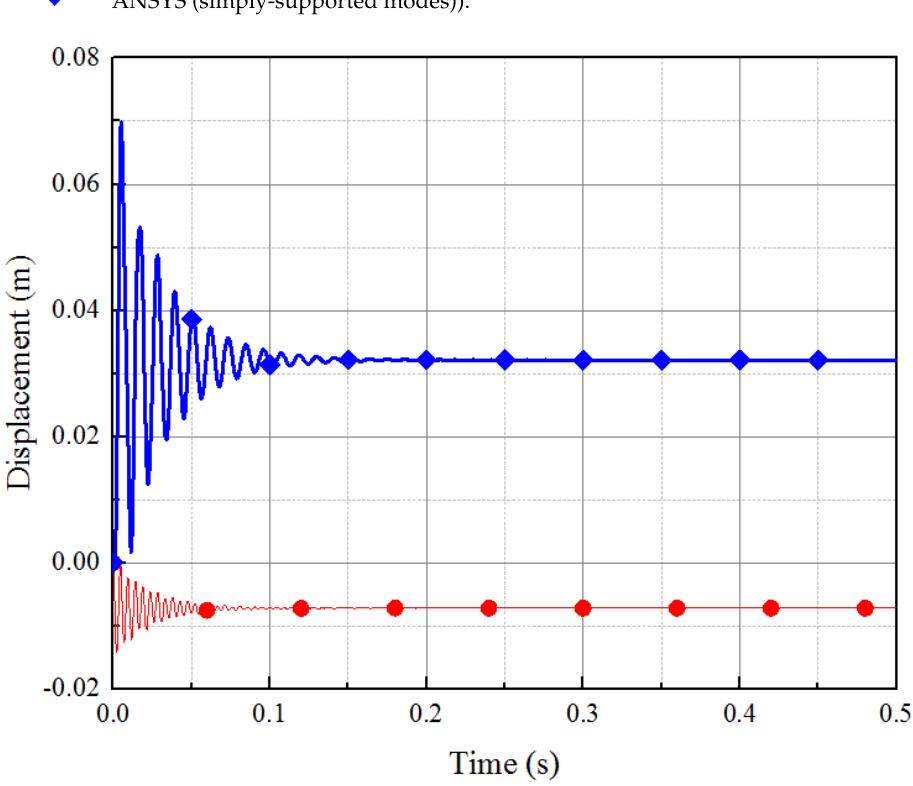
Figure 6. Transverse displacement of the free end node. ( CB method (free-free modes) and ANSYS (simply-supported modes)).